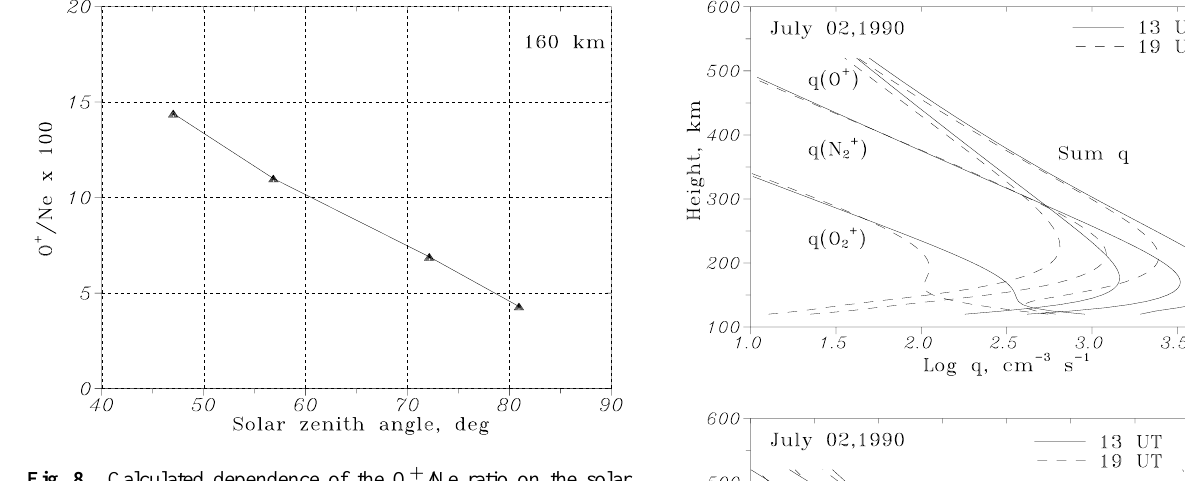
Fig. 8. Calculated dependence of the O + /Ne ratio on the solar zenith angle at a fixed (160 km) height.